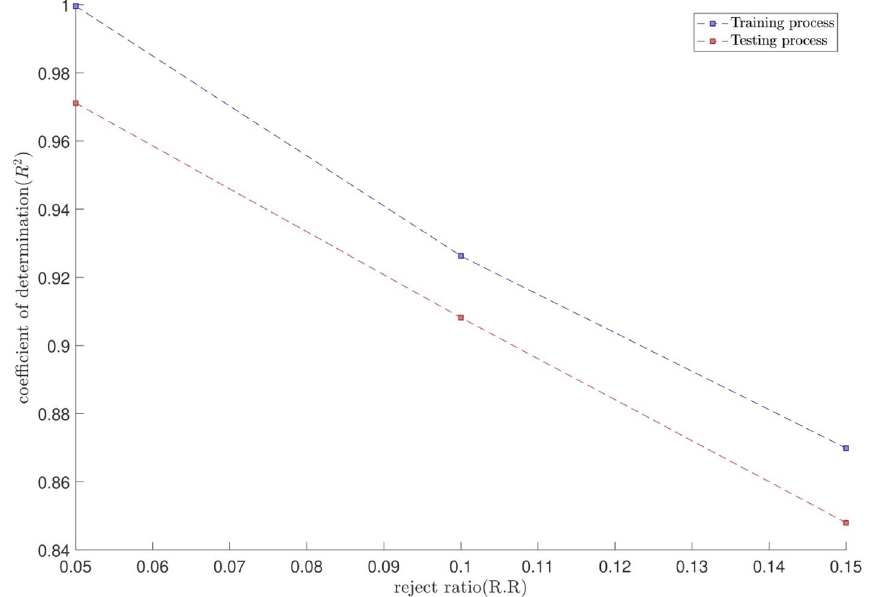
Figure 8. GAFIS method learning processes with changing in reject ratio